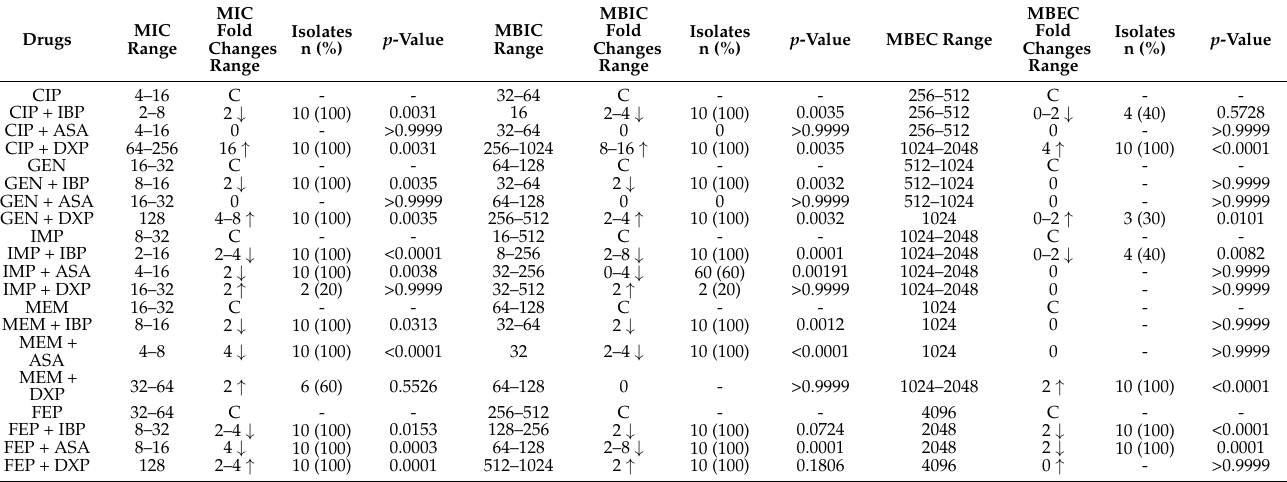
Table 4. The level changes of the MIC, MBIC, and MBEC of antibiotic agents with/without sub-MICs of anti-inflammatory drugs among carbapenem-resistant P. aeruginosa